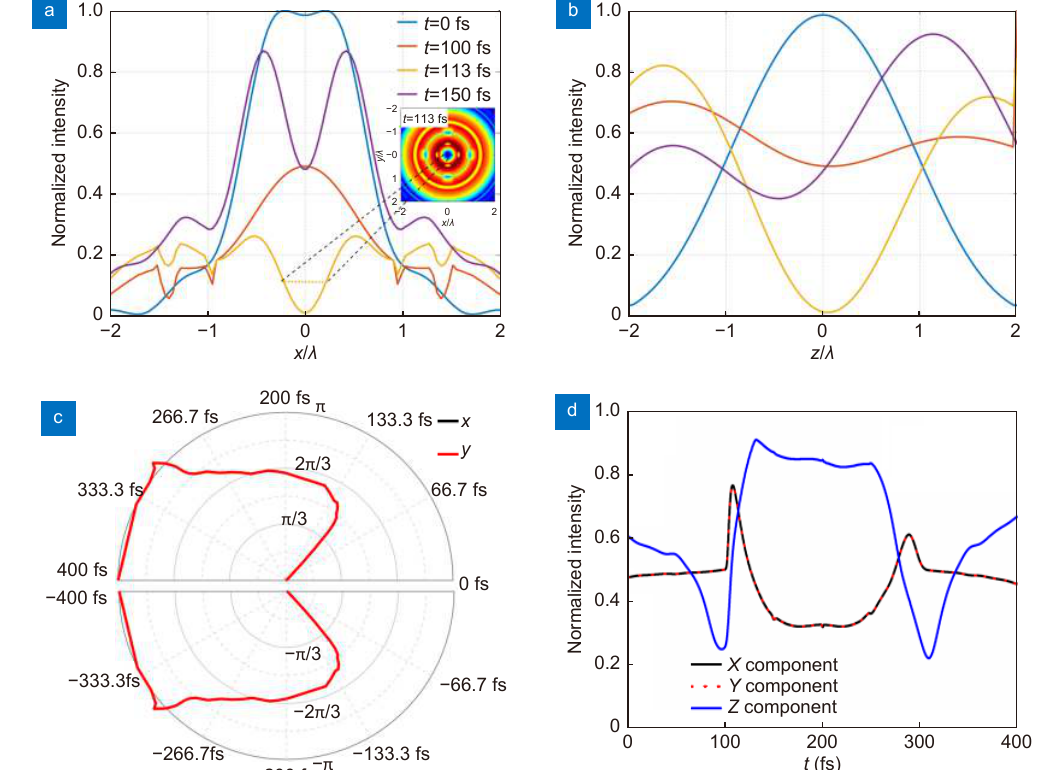
Fig. 6 | Ultrafast multi-target control of the focal light fields for the radially polarized light illumination. ( a ) and ( b ) the intensity distribu- tions of the total focal field along the x and the z axes at different temporal intervals with t = 0 fs, 100 fs, 113 fs, 150 fs. ( c ) the rotational angles of the x / y field components (overlapped) as time elapses. ( d ) the normalized intensity curves of transverse (overlapped black solid line and red dot- ted line) and longitudinal field components (blue solid line) as a function of time during 0–400